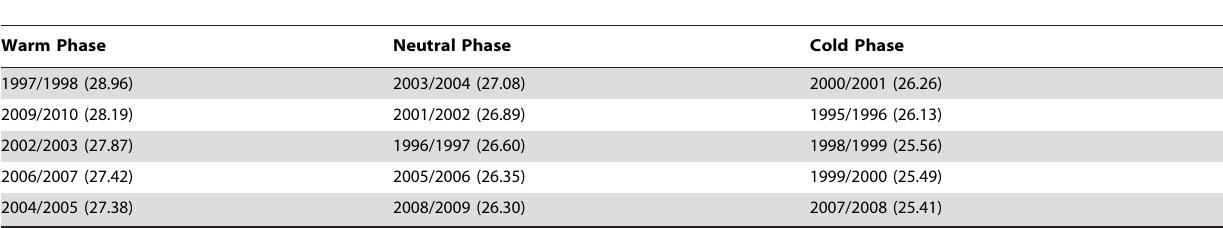
Table 1. ENSO state for the November-April season between 1995/1996 and 2009/2010.